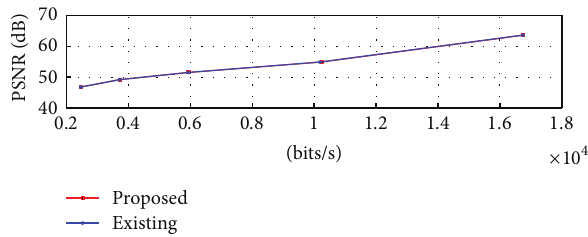
Figure 5: R-D curves for Basketballpass (416 × 240) with standard HEVC quantizer block.